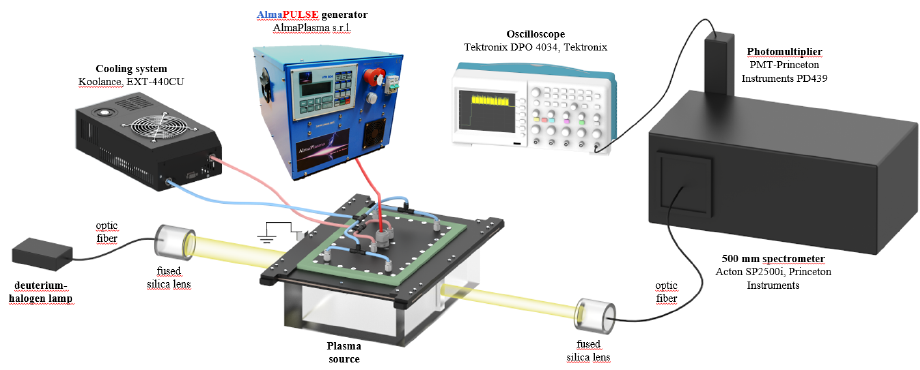
Figure 2. Schematic of the experimental setup for optical absorption